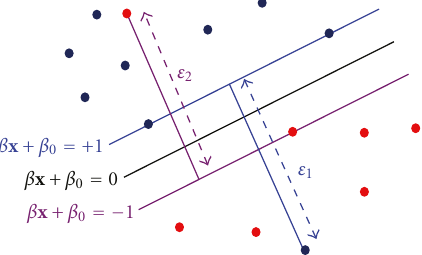
Figure 4: Generalized optimal separating hyperplane.